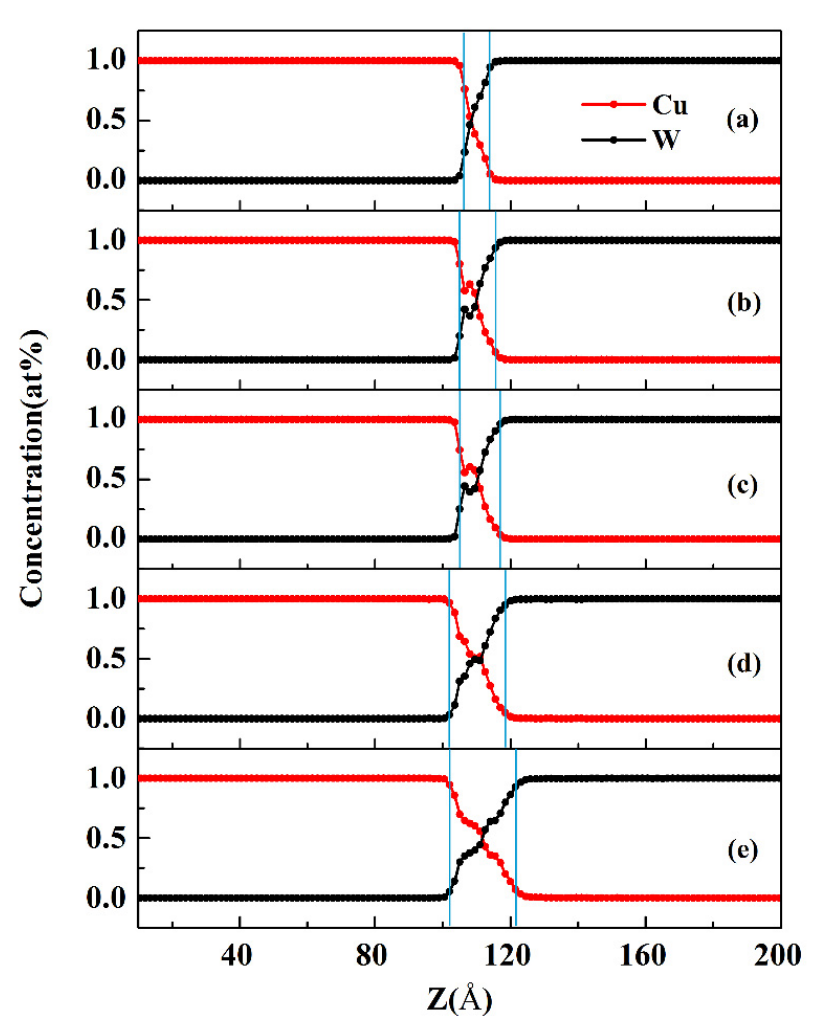
Figure 5. The W-Cu diffusion curves after simulation for 2 ns at different temperatures: ( a ) 900 K,